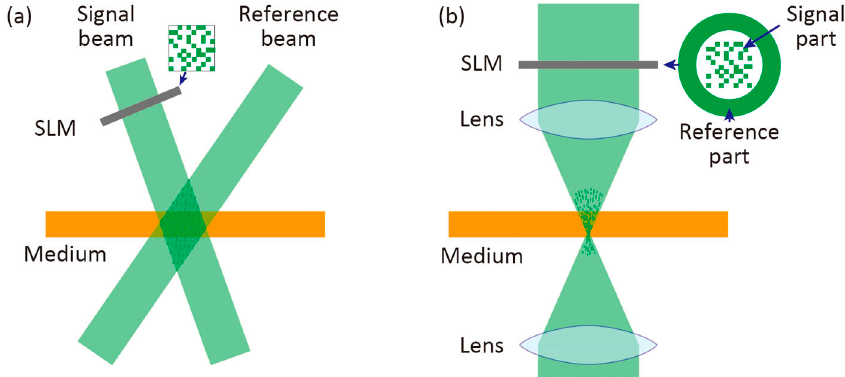
Figure 1. Schematics of ( a ) two-beam interference method and ( b ) collinear interference method.